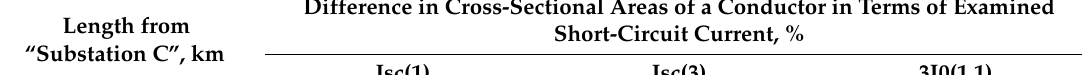
Table 4. Comparison between cross-sectional areas of conductor for “OHL